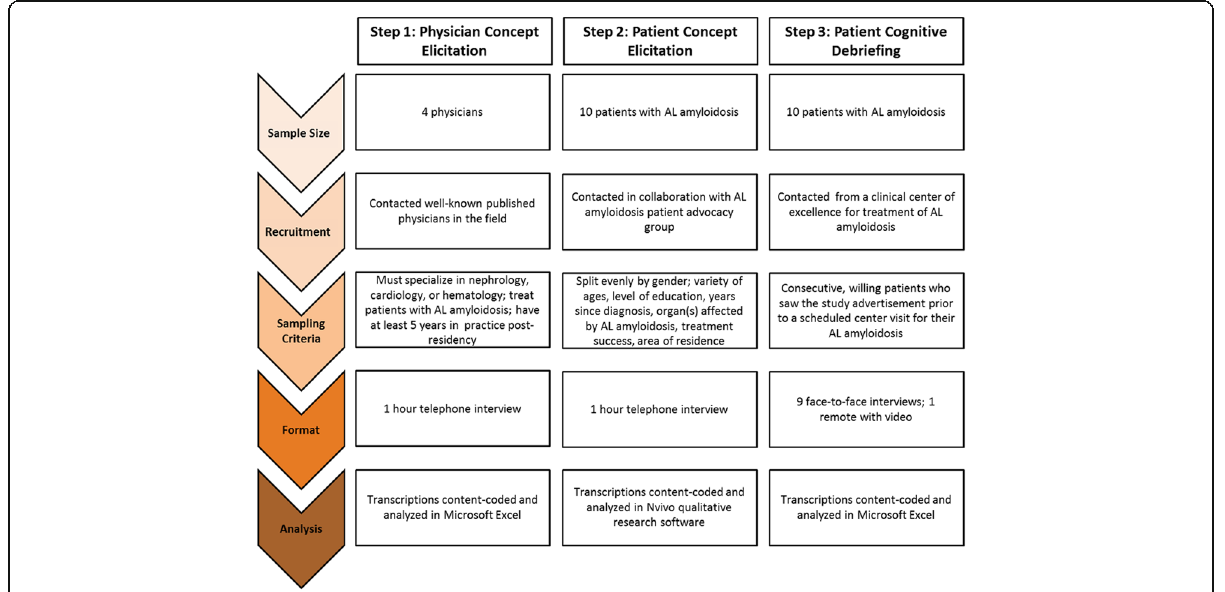
Fig. 1 Description of study methodology, divided by interview